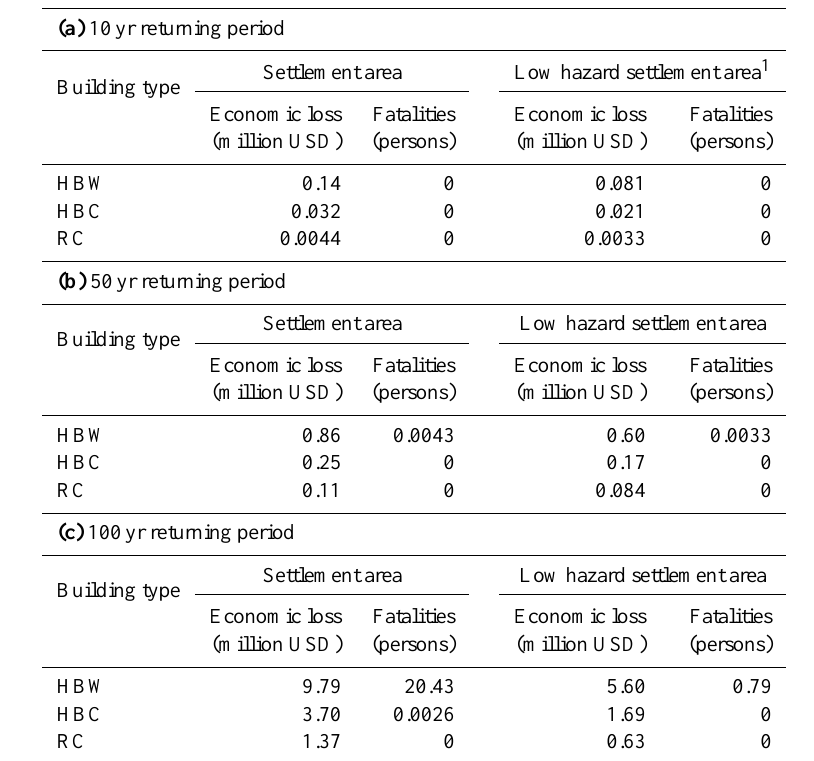
Table 5. Assessed economic loss and fatalities due to damage of buildings caused by potential debris flow events simulated with rainfall events with 10yr (a) , 50yr (b) and 100yr (c) returning